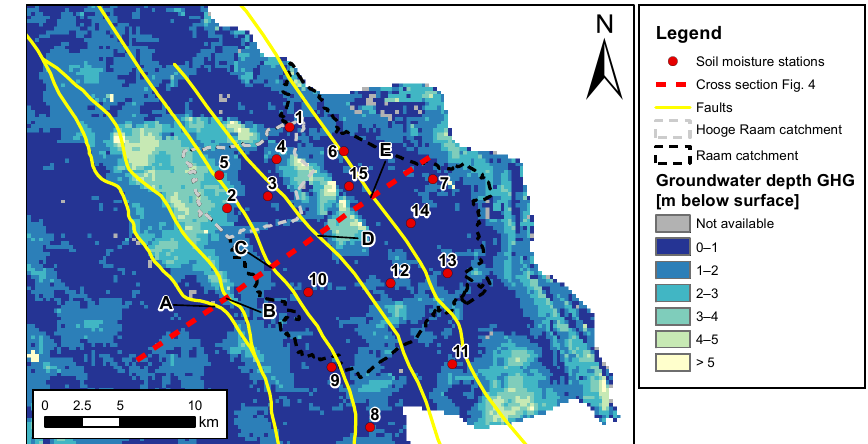
Figure 3. Mean highest groundwater depth (“gemiddeld hoogste grondwaterstand”, GHG) in the Raam catchment. The GHG is a long-term average of highest groundwater depths, defined as the average of the three highest groundwater depths per year over a period of 8 years. The groundwater data originate from the national implementation of the Netherlands Hydrological Instrument, NHI LHM (De Lange et al., 2014). The map also shows the location of faults in the area. The dashed red line represents the cross section that is shown in Fig. 4.